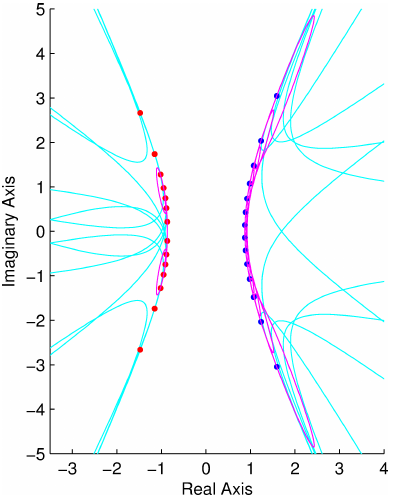
Fig. 1. W J .T/ for Example 5.1